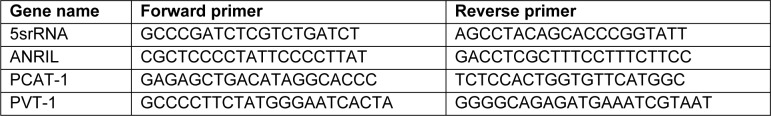
Nucleotide sequence of primers used for expression analysis of lncRNAs in urinary exosomes